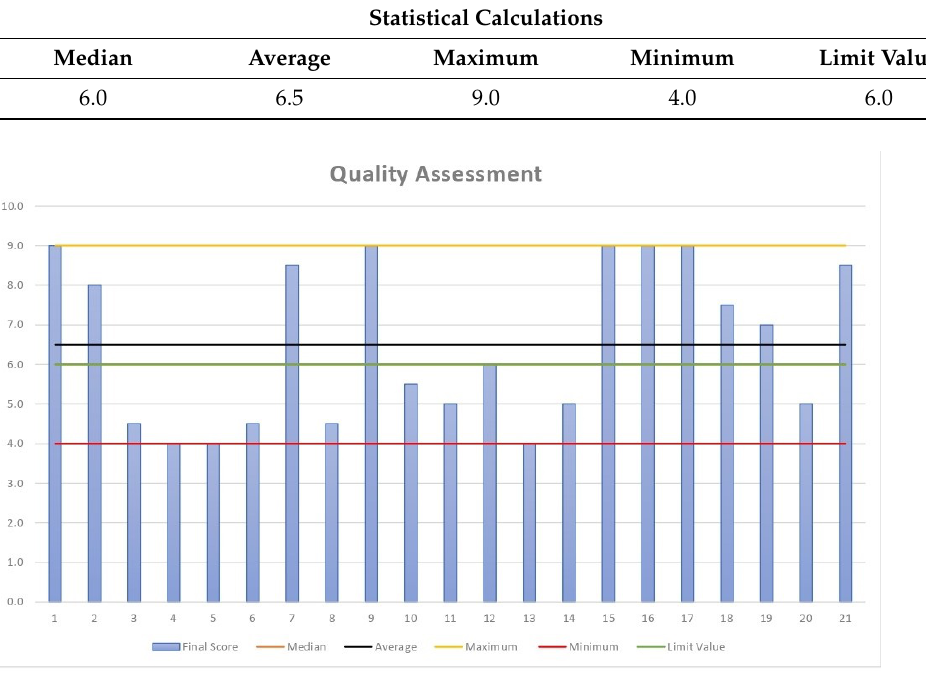
Figure 6. Distribution of quality data.